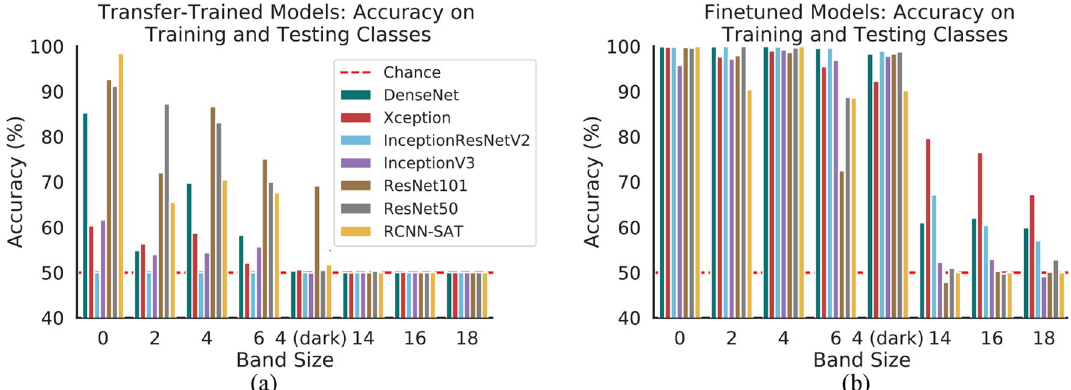
Figure 3. Generalization performance of object recognition DNNs. ( a ) Accuracy for six transfer-trained DNNs (with frozen base models) when classifying new exemplars from training classes or instances of slightly different